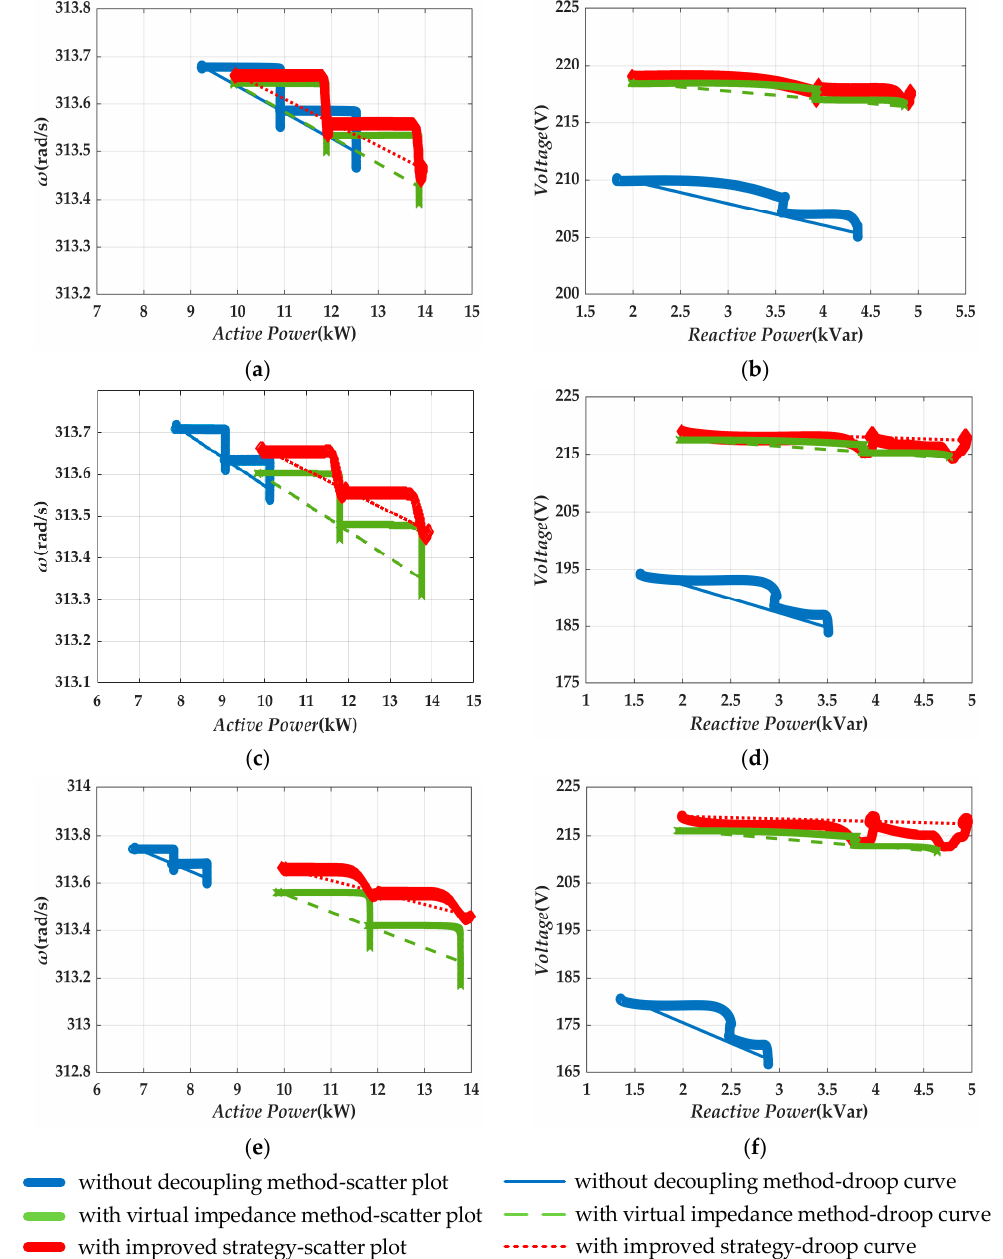
Figure 9. Terminal droop curves of connecting lines with different lengths: ( a ) terminal active power droop characteristics when line length is 1 km; ( b ) terminal reactive power droop characteristics when line length is 1 km; ( c ) terminal active power droop characteristics when line length is 3 km; ( d )